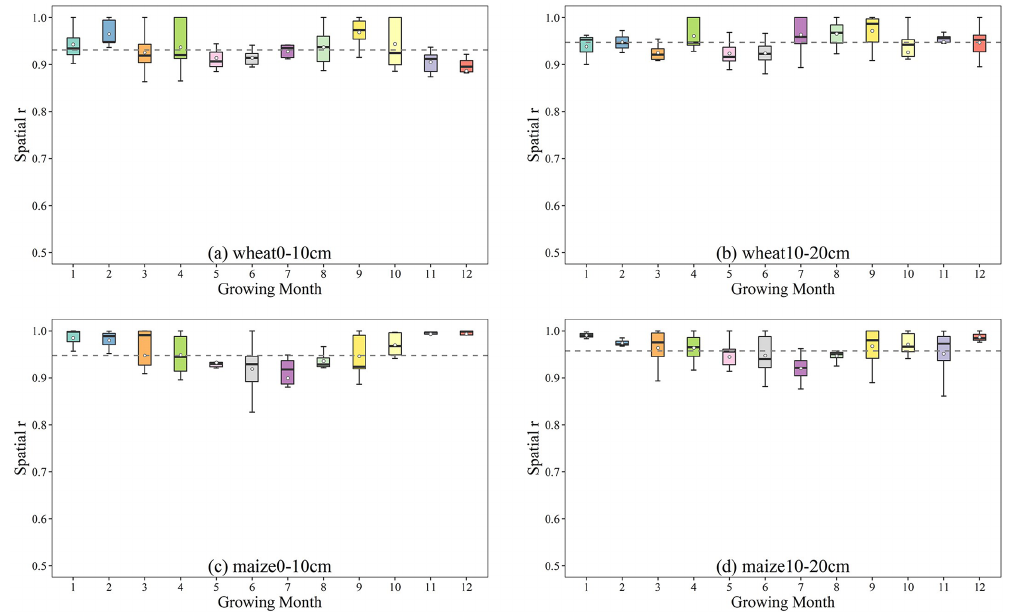
Figure 6. Comparison of the spatial accuracy ( r ) between ChinaCropSM1 km and in situ SM observations in each month by crops and